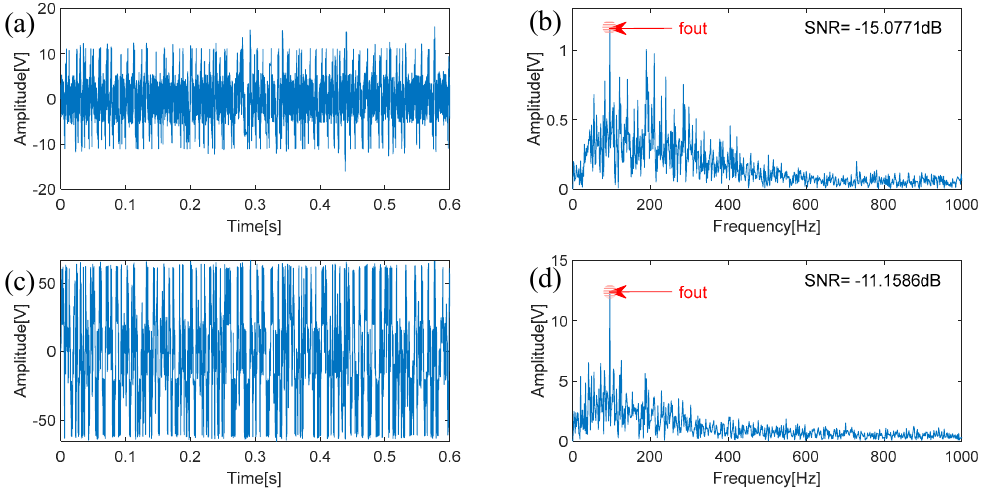
Figure 8. Waveform and spectra of outer ring signals processed by MCCK-based USR method and CSK-based APHSR method.